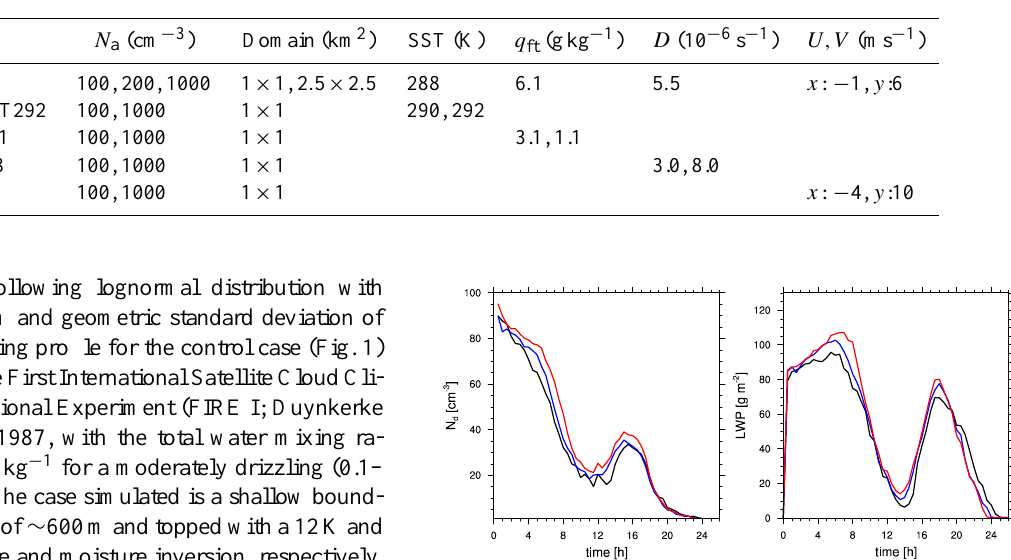
Fig. 2. Time evolution of N d , LWP, and surface precipitation rate under different domain size: 2.5 × 2.5 km 2 (black) and 1 × 1 km 2 (red); under different N a : clean (solid line) and polluted (dashed line) cloud. Table 3. Summary of simulated cases.